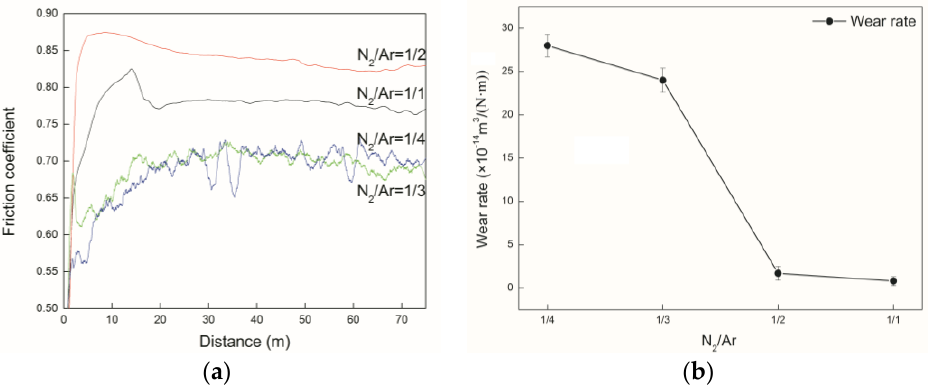
Figure 9. The friction coefficient and the wear rate of the AlCrSiN coatings as a function of N 2 /Ar flow rate: ( a ) friction coefficient of coatings; ( b ) wear rate of coatings.